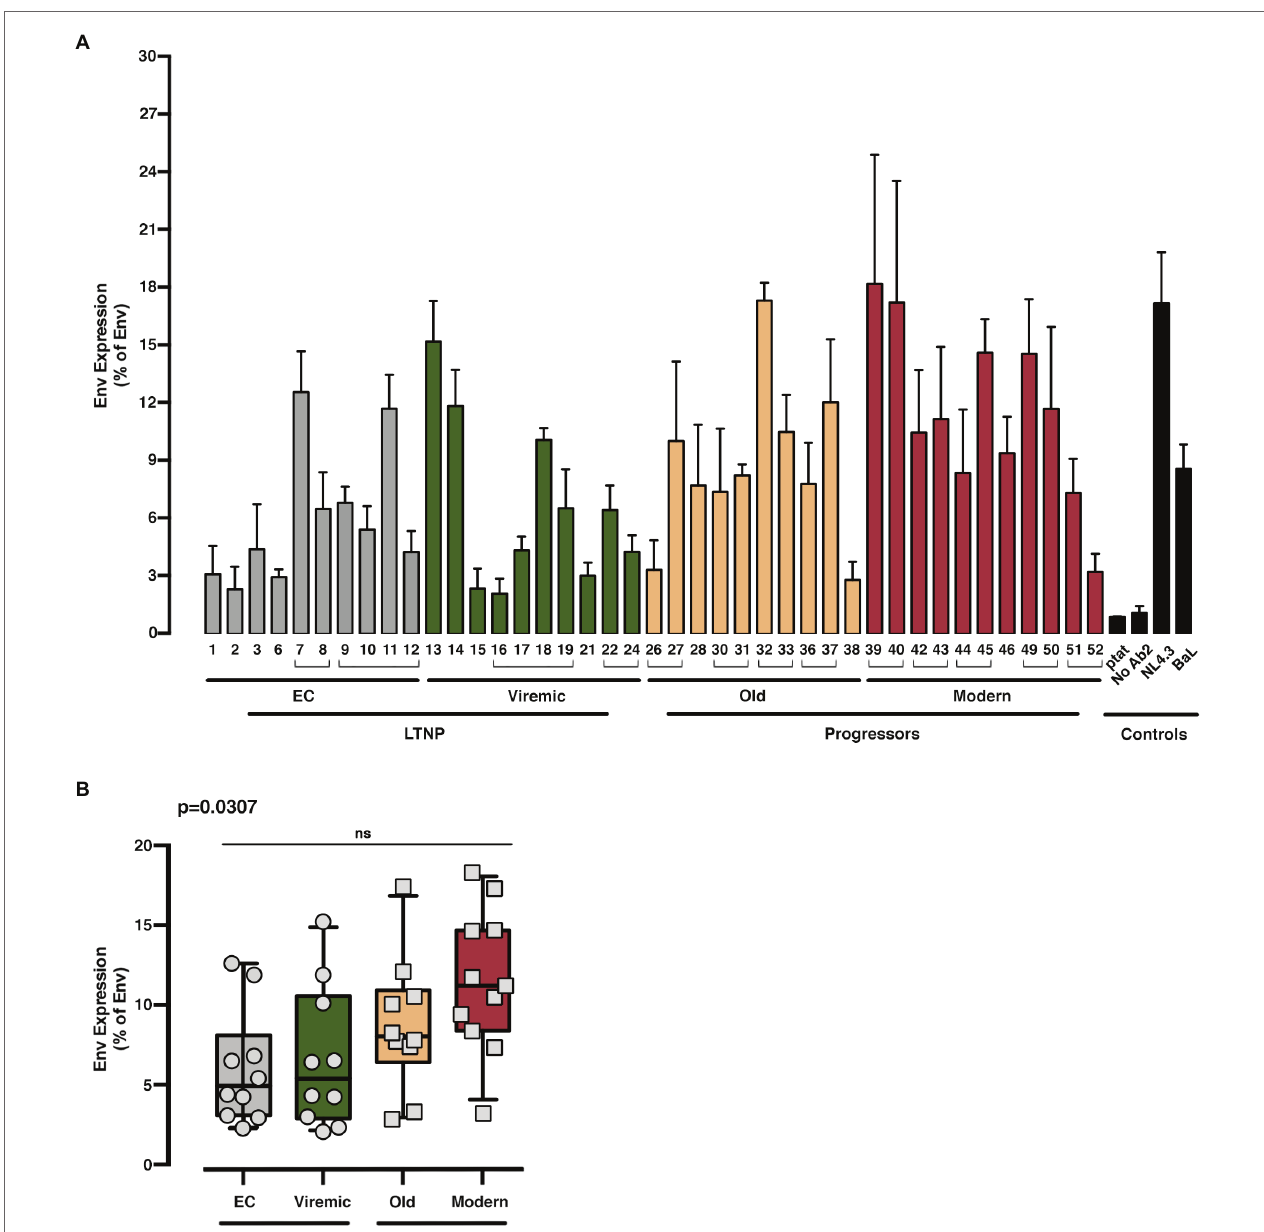
FIGURE 3 | Analysis of the expression of the different HIV-1-Env glycoproteins from LTNP-EC, Viremic LTNP, and control progressors patients. Flow cytometry analysis of the cell-surface expression level of the assayed HIV-1 Envs in HEK-293T cells from LTNP-EC ( gray bars ), vLTNP ( green bars ), Old ( orange bars ), and Modern individuals ( red bars ) or reference HIV-1 viral strains (ptat, No Ab2, NL4.3, and BaL, black bars ). Env protein expression for each patient (A) and Env protein expression in each group of patients comparing mean values between each group (Kruskal–Wallis, Dunn’s Multiple Comparisons Test; B ) are shown. Envs isolated from the same patient are associated with brackets in (A) ; value of p (Kruskal–Wallis test) for comparison between all groups is shown, top left . No significant (ns) differences were identified after multiple comparison analysis. Values are mean ± SEM of three independent experiments ( n = 3). When indicated, comparative p values between groups are *** p <0.001 and **** p